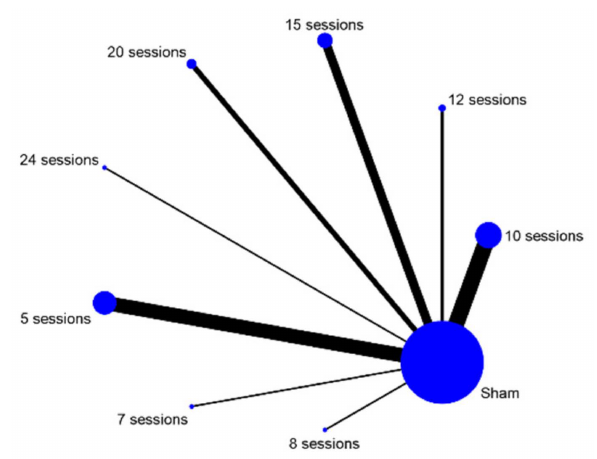
Figure 6. Network map electrode montage.